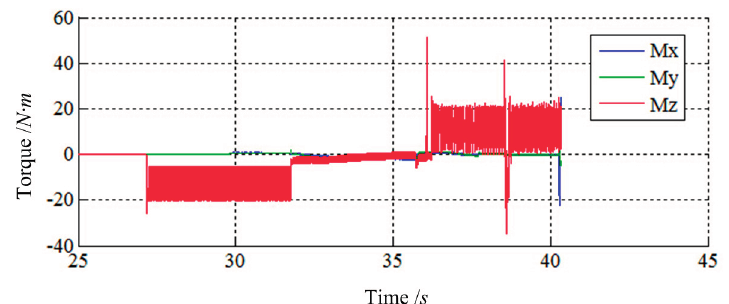
Figure 12. The torque tracking results of Case